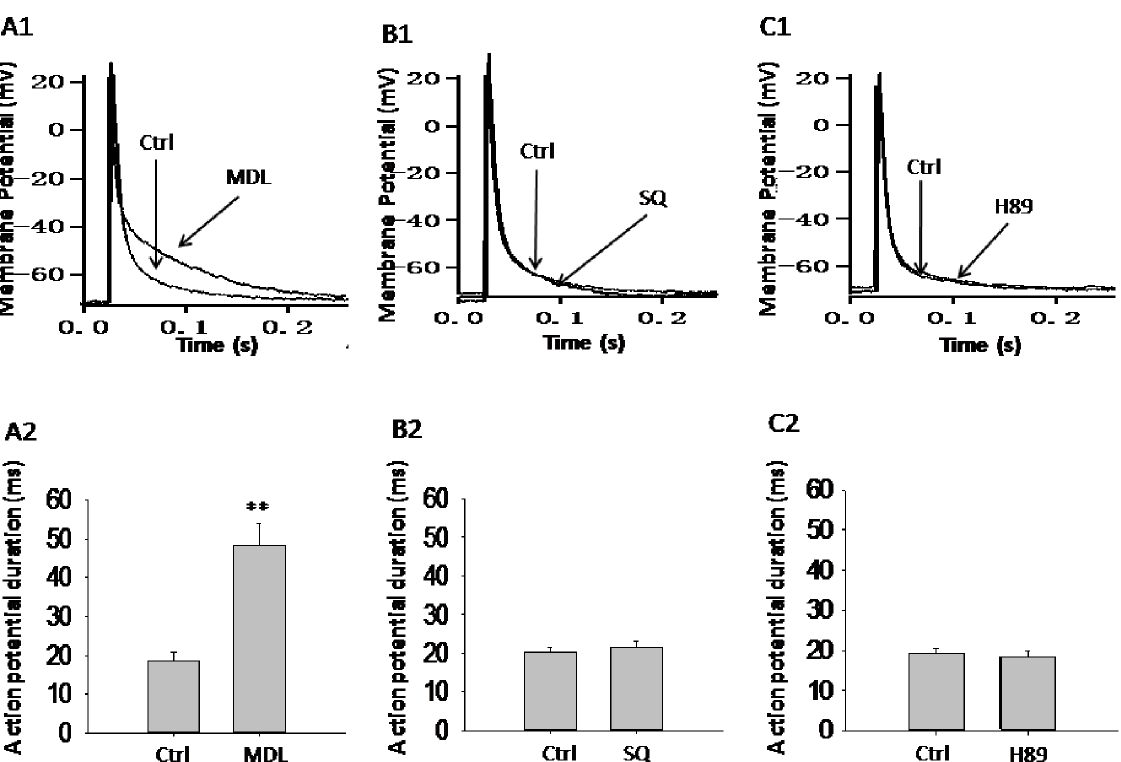
Figure 2. MDL-12,330A, but not SQ 22536, produces prolonged APDs. Pancreatic beta cells were seeded on glass coverslips and cultured in culture dish for 24 h in medium containing 11.1 mM glucose prior to experiments. The coverslip with beta cells was then transfered to recording chamber containing extracellular solutions for patch-clamp experiments. Artificial APs were elicited by applying 4 ms, 150 pA current injections in perforated whole-cell configuration and were recorded before and 2 min after application of reagents in the same cell. Representative action potential waveforms and summary of mean APDs were shown for cells treated with MDL-12,330A (MDL, 10 m M, n=6), SQ 22536 (SQ, 10 m M, n=7) or H89 (1 m M n=7) at 11.1 mM glucose (Ctrl) conditions. **p ,